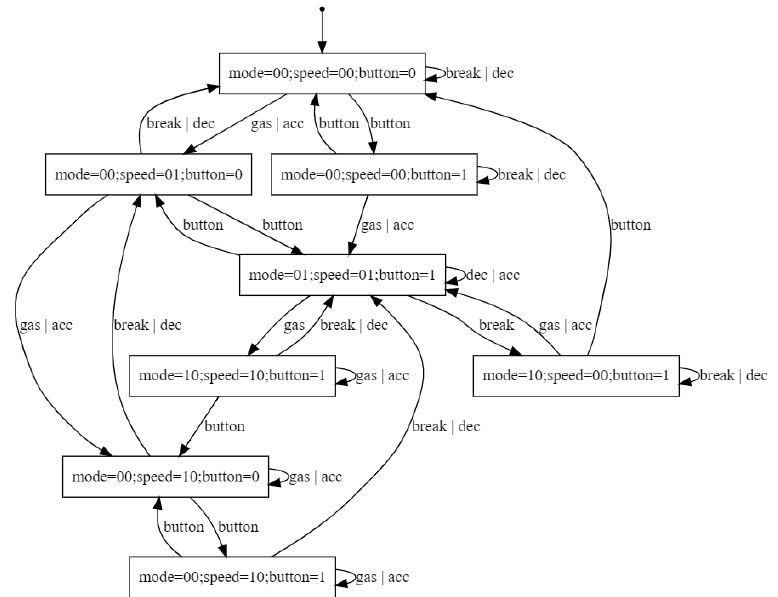
Figure 5. Cruise controller: DFA model.